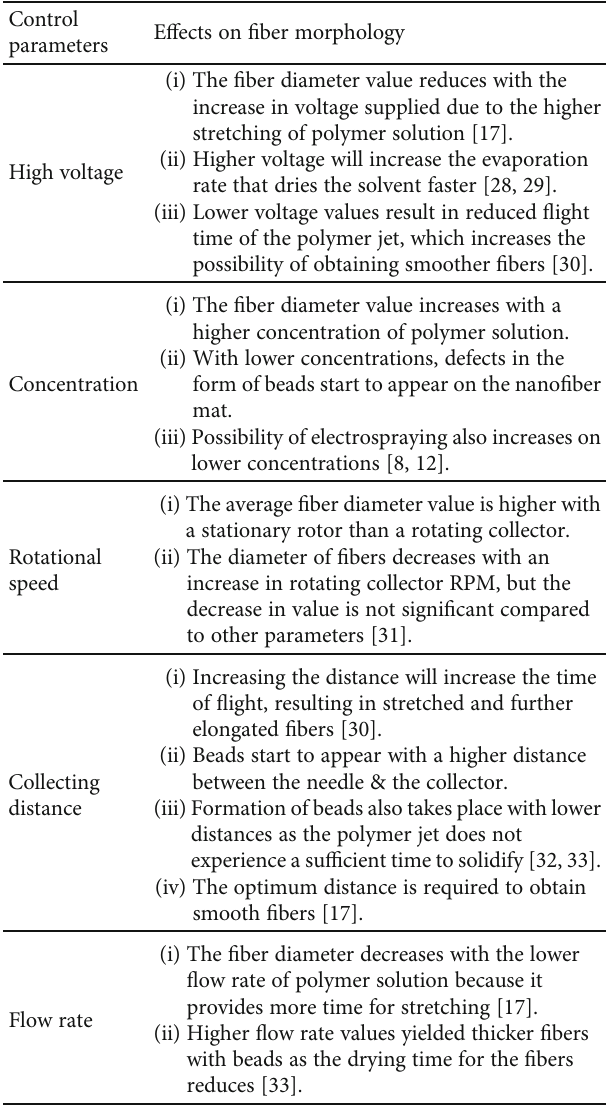
Table 1: E ff ect of electrospinning factors on fi ber